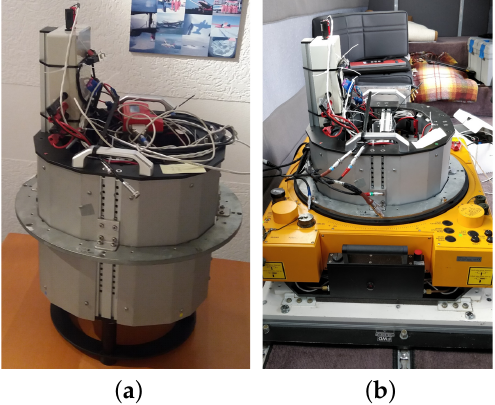
Figure 3. ( a ) Measurement devices placed within a camera sensor pod. ( b ) Photogrammetery mount within the aircraft on which the sensor pod is